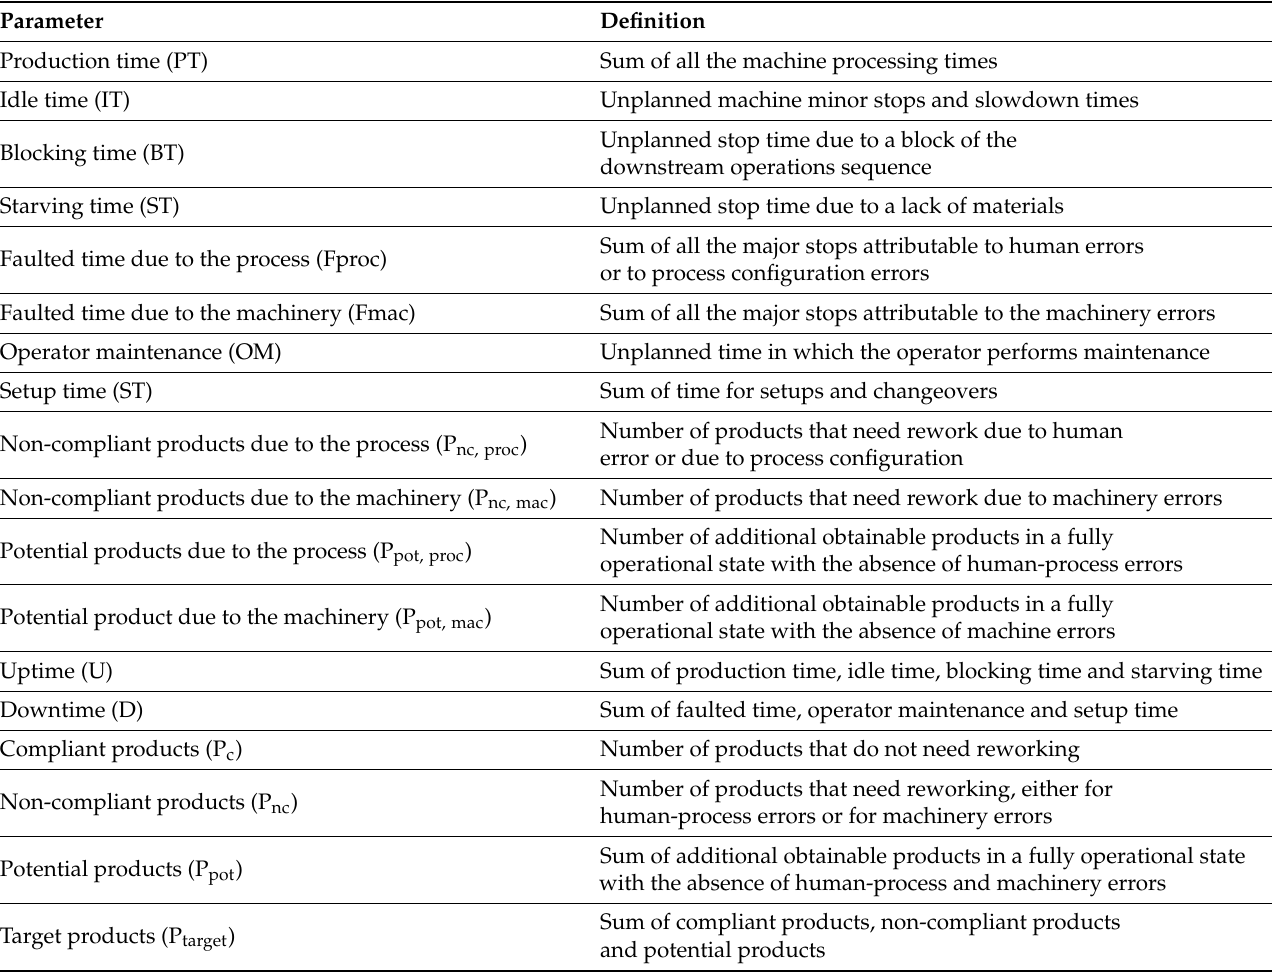
Table 3. Definition of metrics used for the OEE evaluation